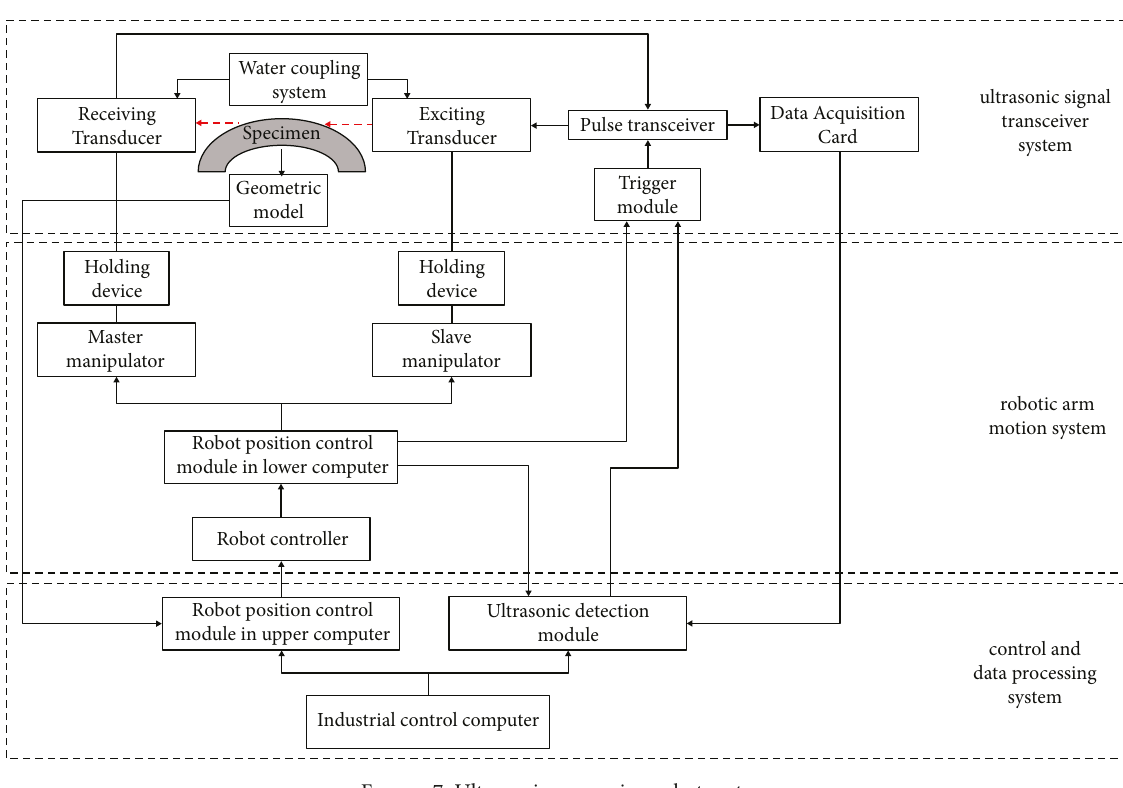
Figure 7: Ultrasonic measuring robot